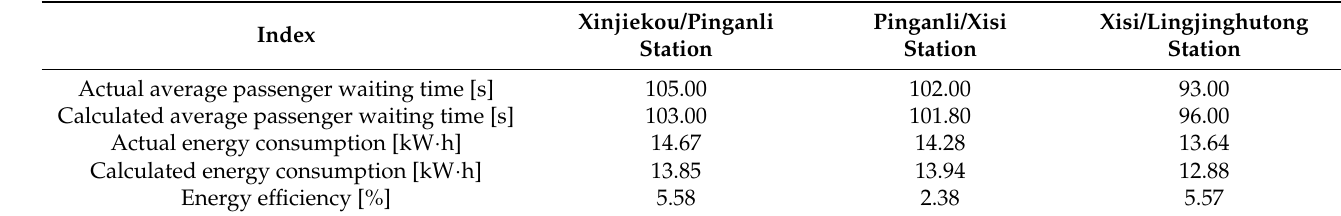
Table 6. Comparison of optimization results.